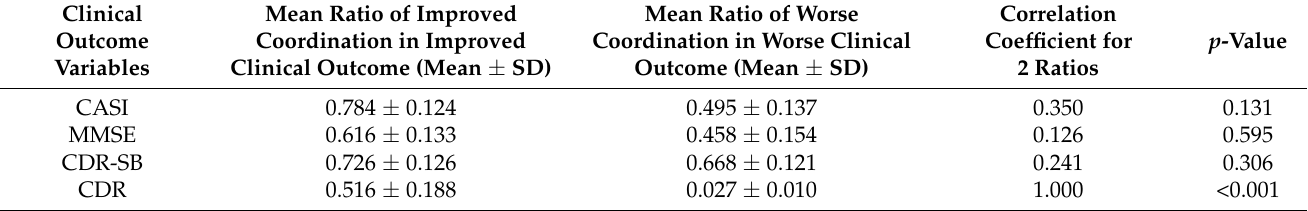
Table 3. Association between coordination function and various clinical outcome measurements in the upper